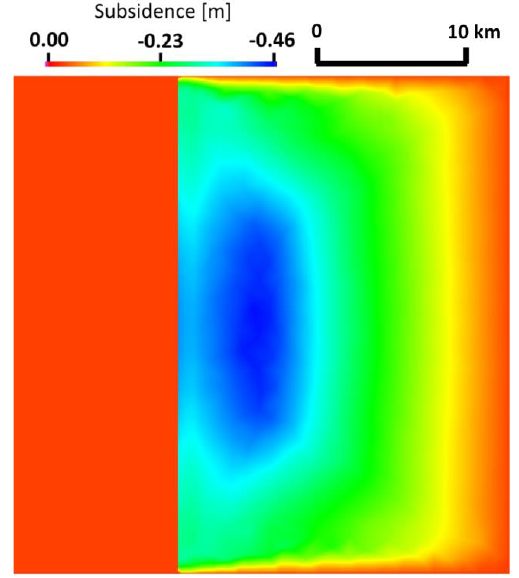
Figure 7. Test case 2: land subsidence after 10 years of water ex-